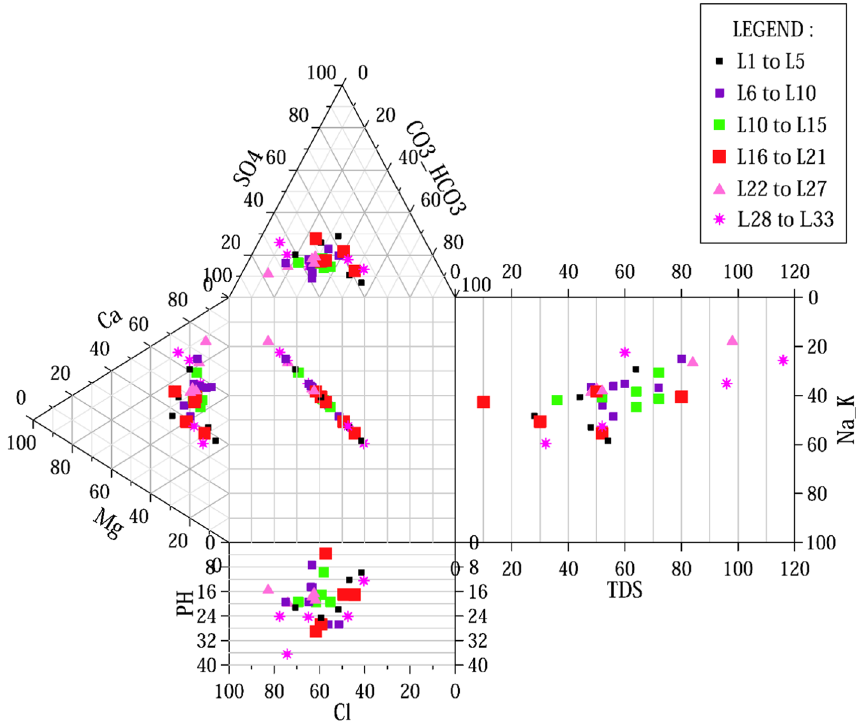
Fig. 3 Expanded Durov dia- gram for depicting evolution of hydrochemical facies in